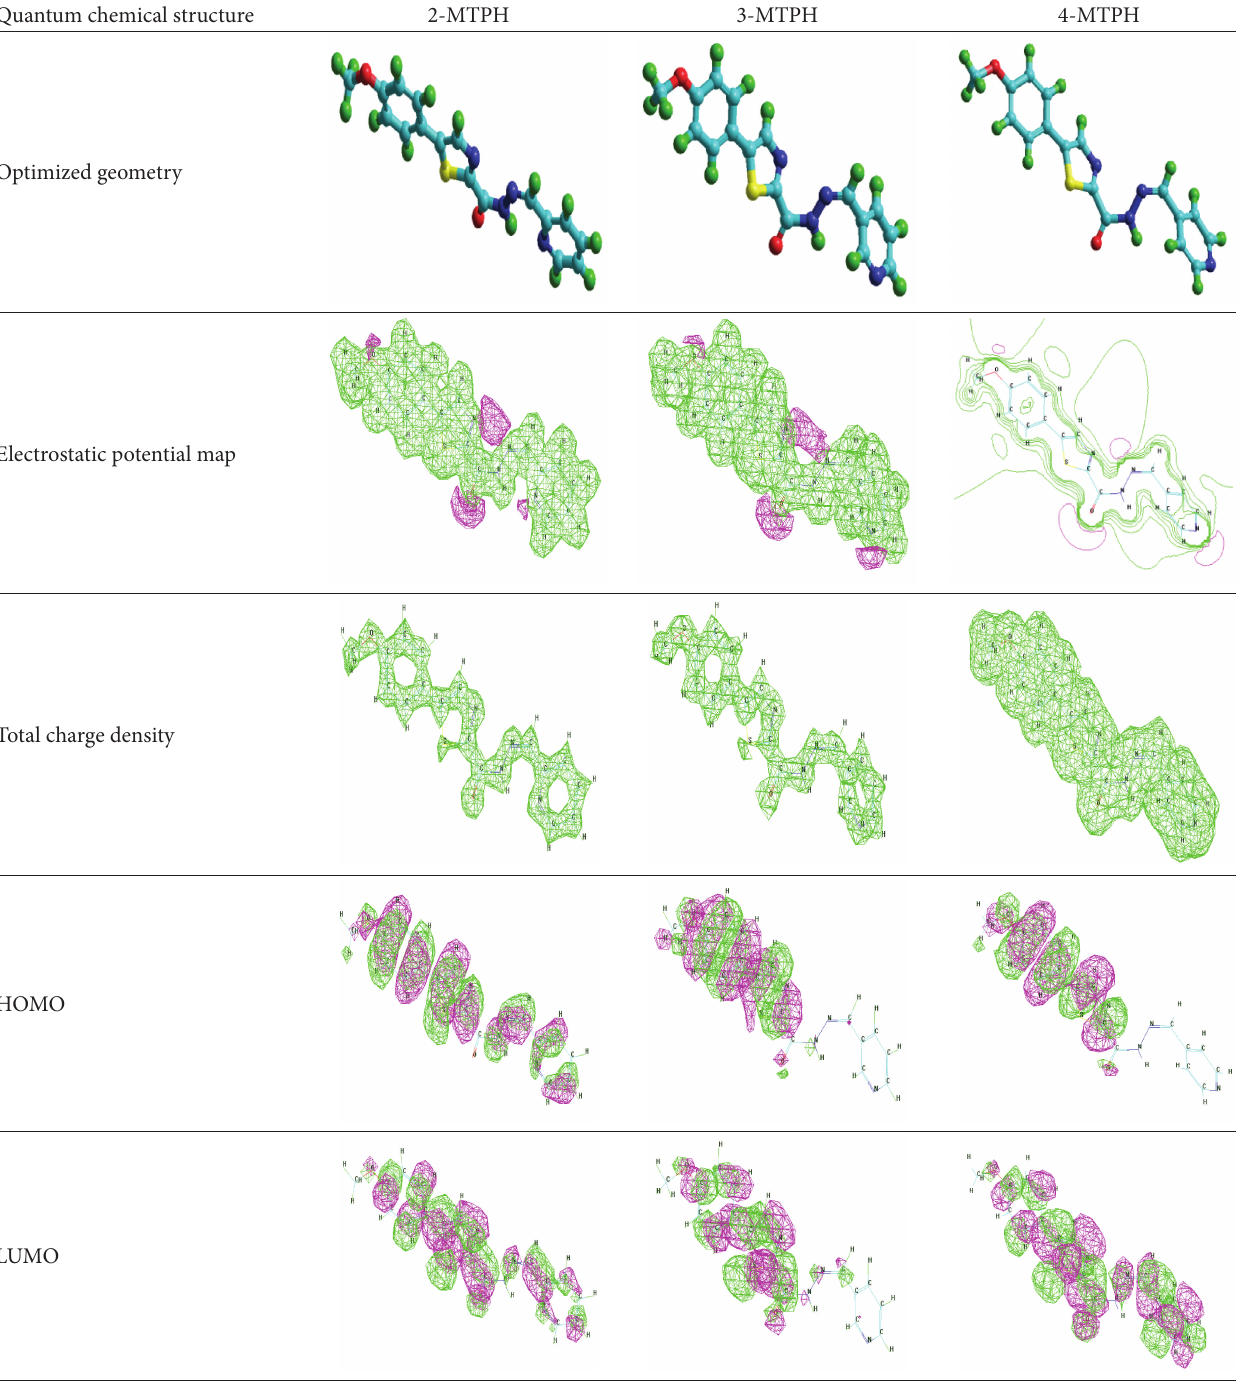
Table 9: List of quantum chemical